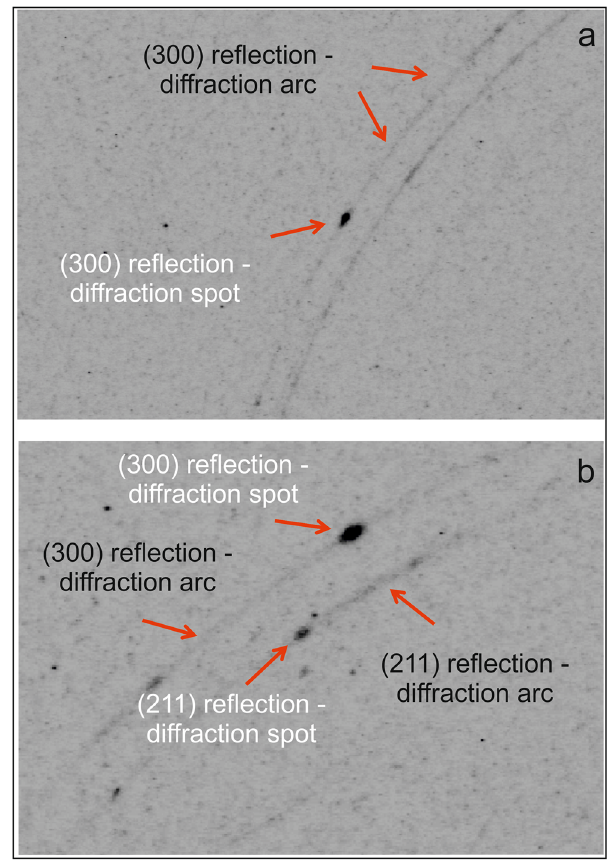
Figure 5. Diffraction signals. Detail of the bidimensional image obtained by μ XRD measurement in one point of the surface of the conodont element. ( a ) Specimen IPUM 28983 ( Amorphognathus sp., Pb element - point 7 in Fig. 6- centre). ( b ) Specimen IPUM 28986 ( Amorphognathus sp., Pb element - point 5 in Fig. 6- right